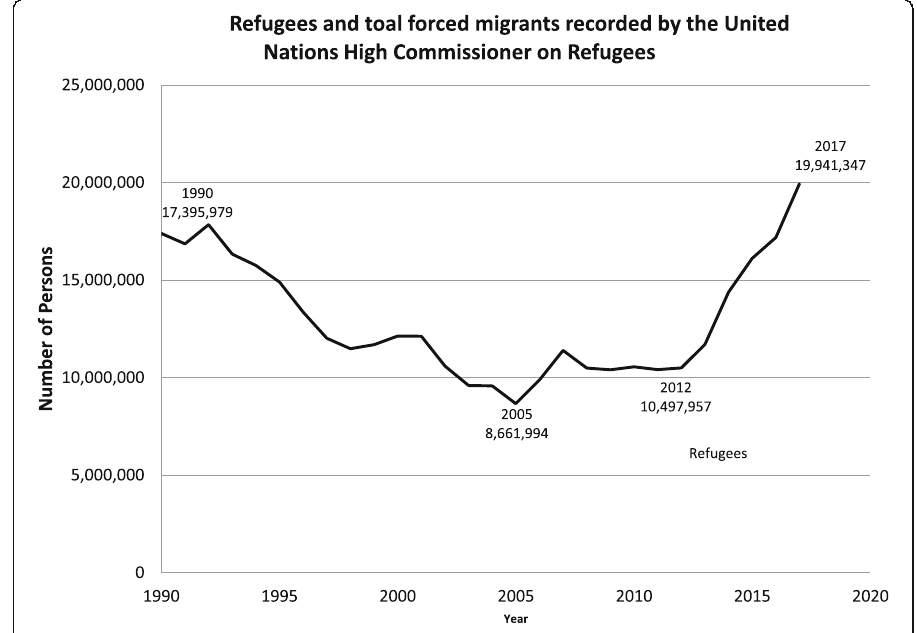
Fig. 11 Refugees and total forced migrants recorded by the United Nations High Commissioner on